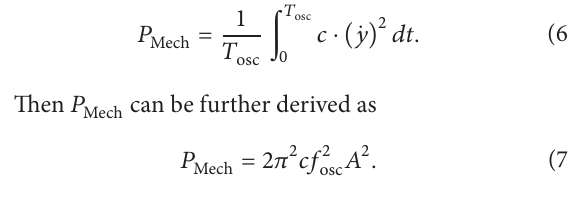
velocity; 𝐷 is the characteristic dimension of the body normal to the flow (for circular cylinder, 𝐷 is the diameter of the cylinder); and 𝐿 is the length of cylinder. Then the equation of motion could be derived